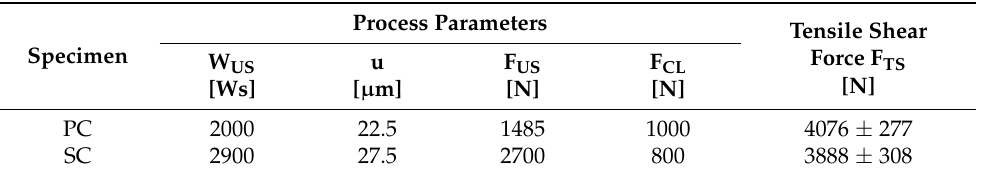
Table 3. Parameter sets for ultrasonic spot welding of PC and SC with the highest tensile shear forces F TS and best reproducibility: welding energy (W US ), oscillation amplitude (u), welding force (F US ), additional clamping force (F CL ) and tensile shear force (F TS